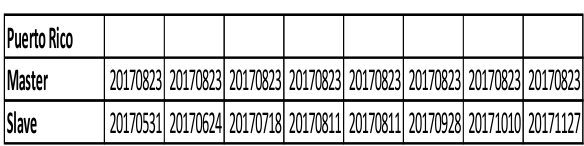
Table 2: Master and slave images selected for experiments in Puerto Rico